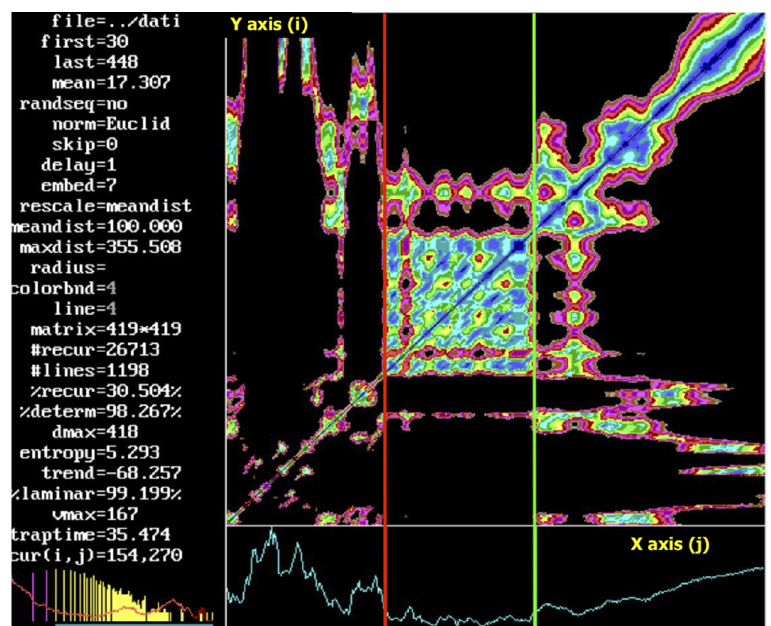
Figure 5. Unthresholded recurrence plot of the RR time series (ms) (light blue line) recorded as a breath-by-breath, from a cardiopulmonary exercise test (CPET) device (Cosmed, Rome, Italy). The red and green lines show the change of pattern at the first and second threshold, respectively. On the horizontal and vertical axes, the j-th and i-th indices are reported, respectively. (For more details see in Appendixes A.3 and A.4).